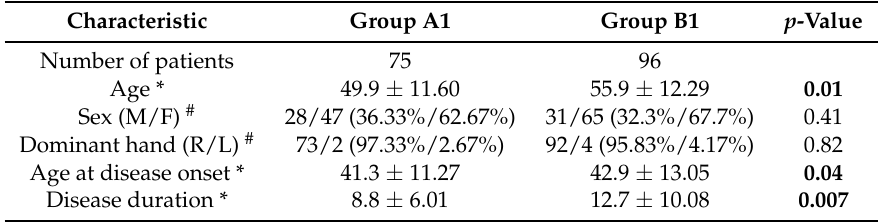
Table 1. Clinical and demographic characteristics of the patients belonging to groups A1 and B1 (statistically significant p -values ( p < 0.05) are highlighted with bold font). Characteristic Group A1 Group B1 p -Value